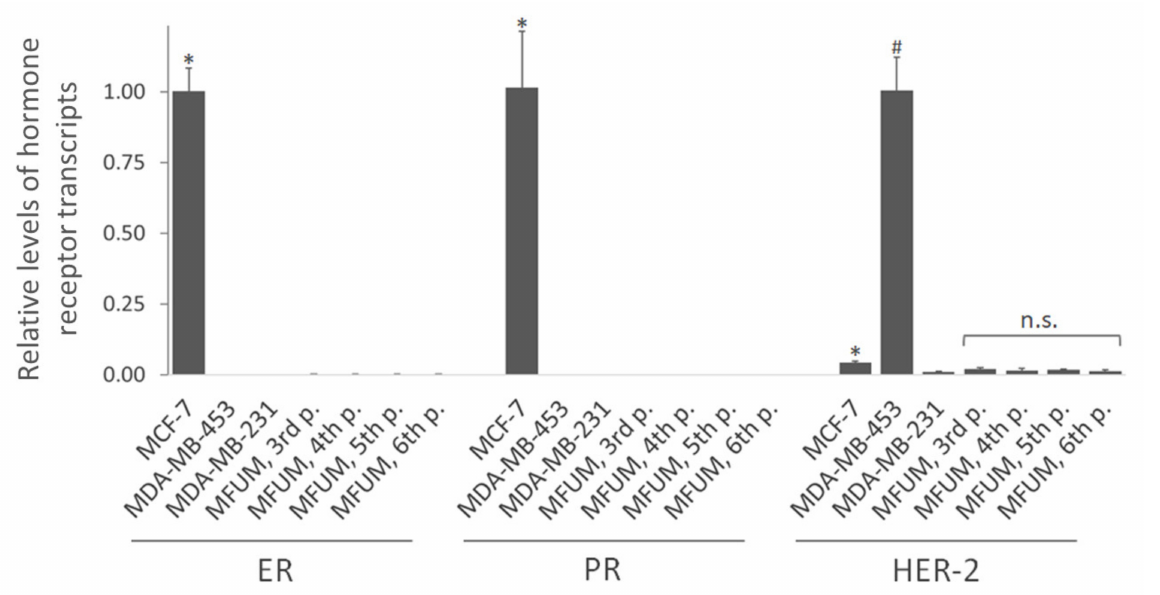
Figure 4. Relative levels of hormone receptor transcripts (ER- α , PR and HER-2) by qRT-PCR. Leg- end: Relative levels of hormone receptor transcripts in MFUM-BrTNBC-1 and commercial BC CLs MCF-7, MDA-MB-453 and MDA-MB-231 were analysed by qRT-PCR. The level of ER and PR tran- scripts in MCF-7 cells is presented as 1, while the transcript level of HER-2 is presented as 1 in MDA- MB-453 cells. Comparison of receptor expression in MCF-7 (ER + PR + HER-2 − ) versus other lines: * p < 0.05, Mann-Whitney U-test. Comparison of HER-2 expression in MDA-MB-453 (ER − PR − HER-2 + ) versus other lines: # p < 0.05, Mann–Whitney U-test. Differences in HER-2 expression between MFUM- BrTNBC-1 passages (MFUM 3rd, 4th, 5th and 6th p.): n.s. (not significant), ANOVA with Tukey post